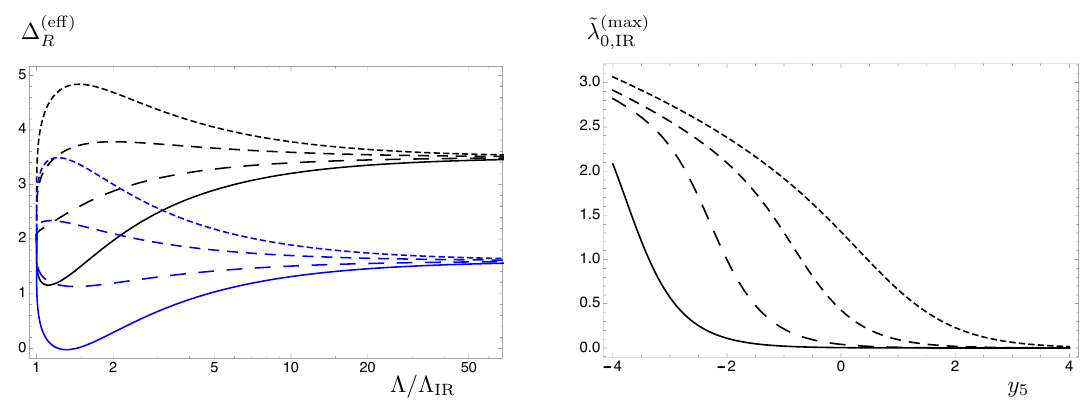
Figure 13 . Model II. Both panels have ∆ = 3 , x F = 1 , ∆ φ = 1 , and φ c = 1 . 5 . The left panel shows the effective scaling dimension ∆ (eff) as a function of the energy scale Λ , for y 5 = 1 . 5 , 0 . 5 , − 0 . 5 , − 1 . 5 R (short-dashed to solid lines), and two choices ∆ R = 1 . 6 , 3 . 5 (in blue, black). The right panel shows the maximum IR value ˜ λ (max) as a function of y 5 , for Λ UV ’ 10 3 , and ∆ R = 1 . 51 , 2 . 5 , 3 , 3 . 4 0 , IR Λ IR (short-dashed to solid lines).